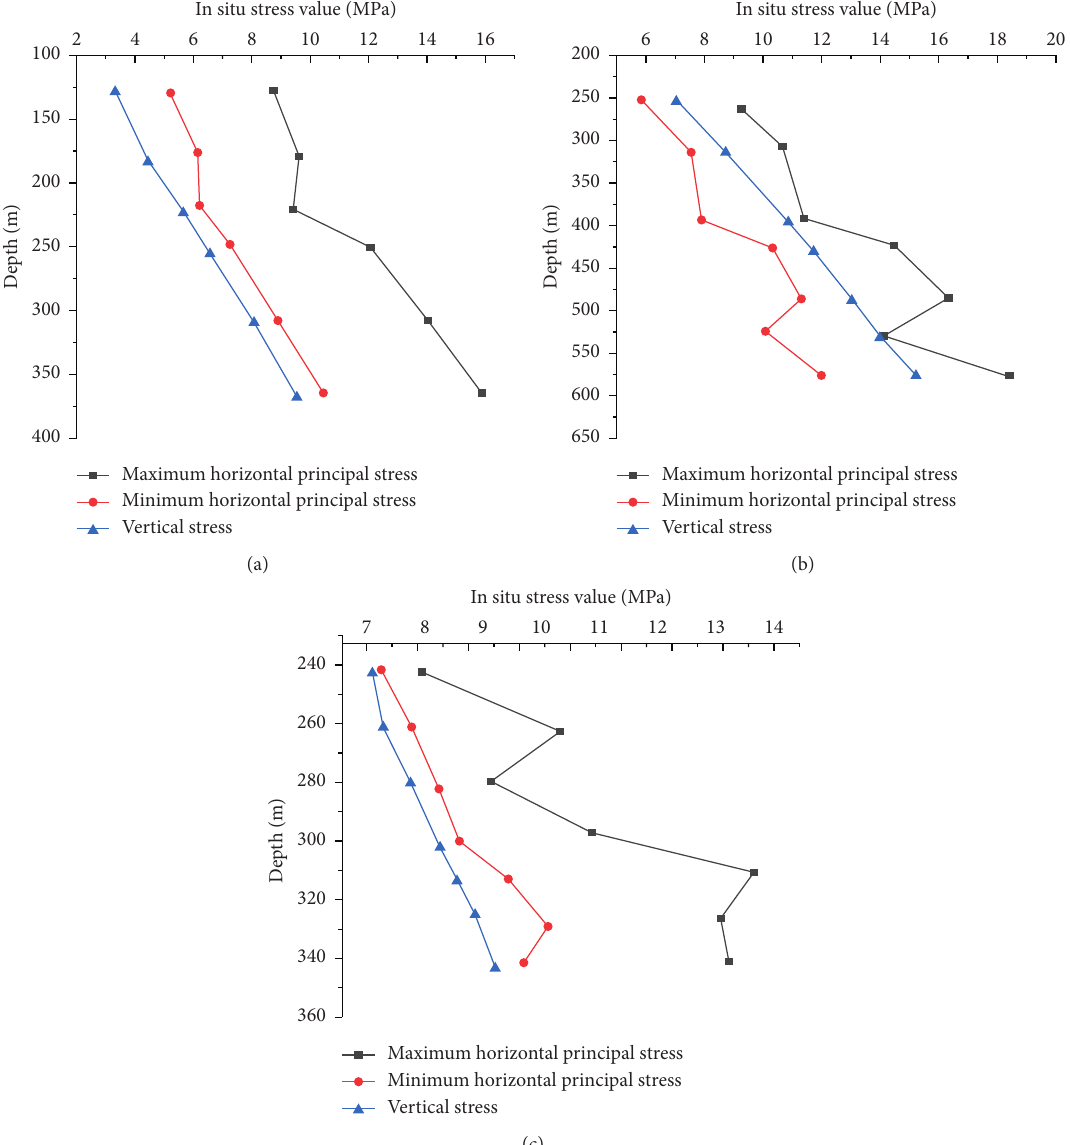
Figure 2: Initial stress change rule of test value with depth. (a) In situ stress test 1#. (b) In situ stress test 2#. (c) In situ stress test